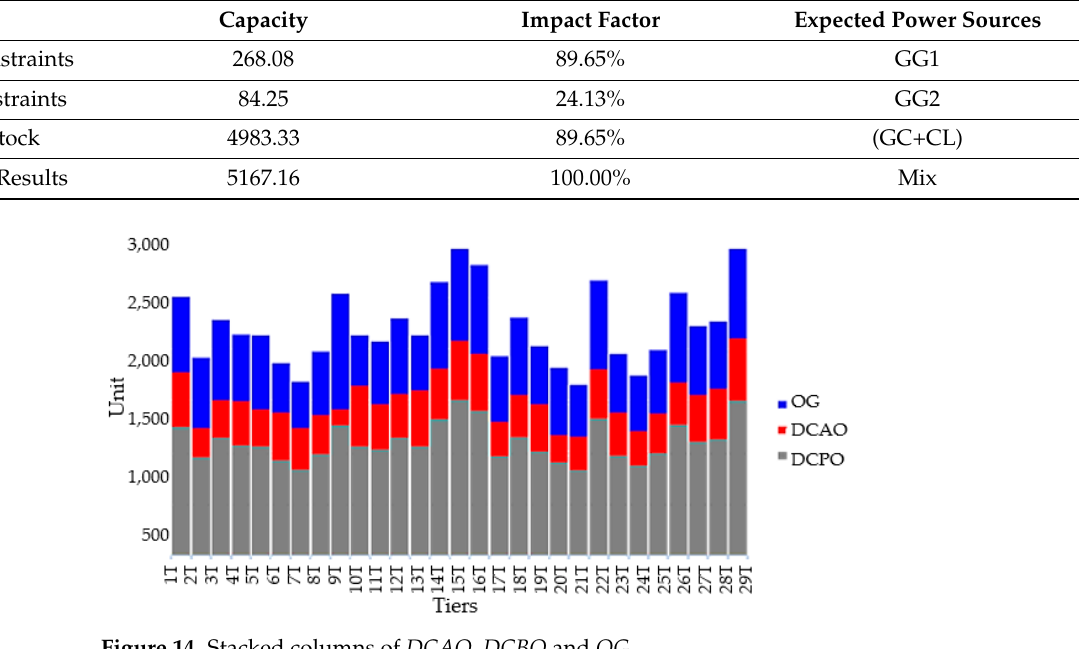
Table 7. Comparing Losses Cost of Simulation and Optimisation.